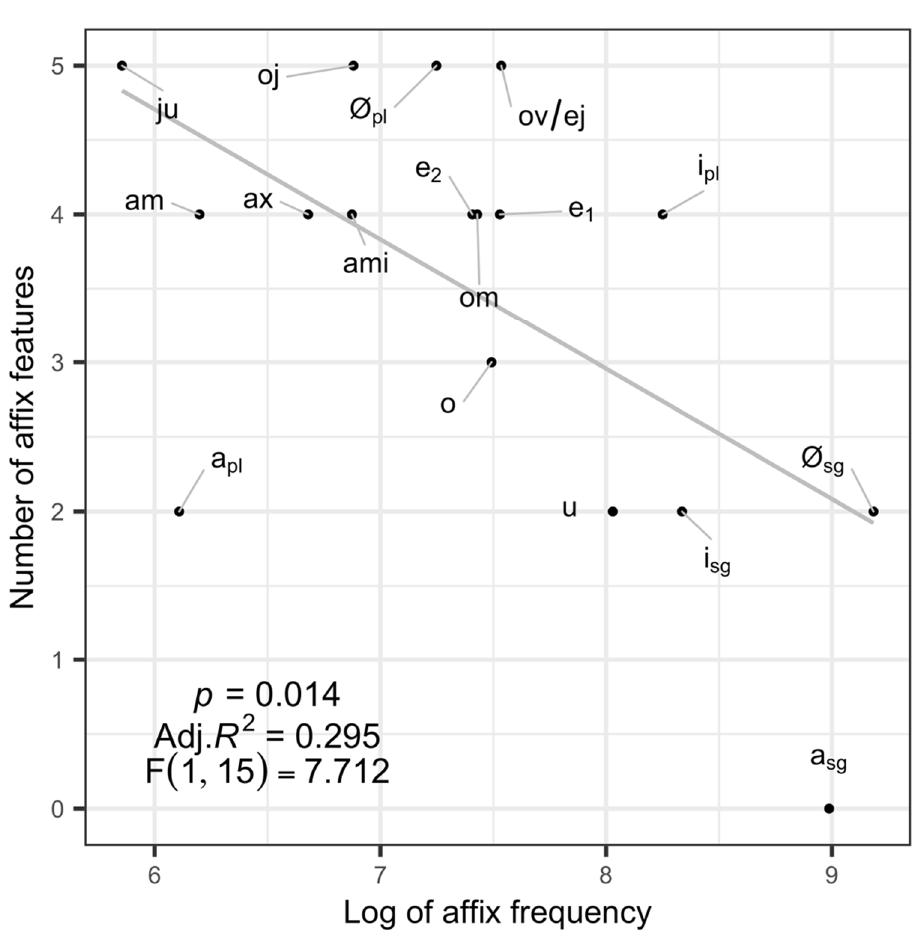
Figure 1. Correlation between affix frequency and affix